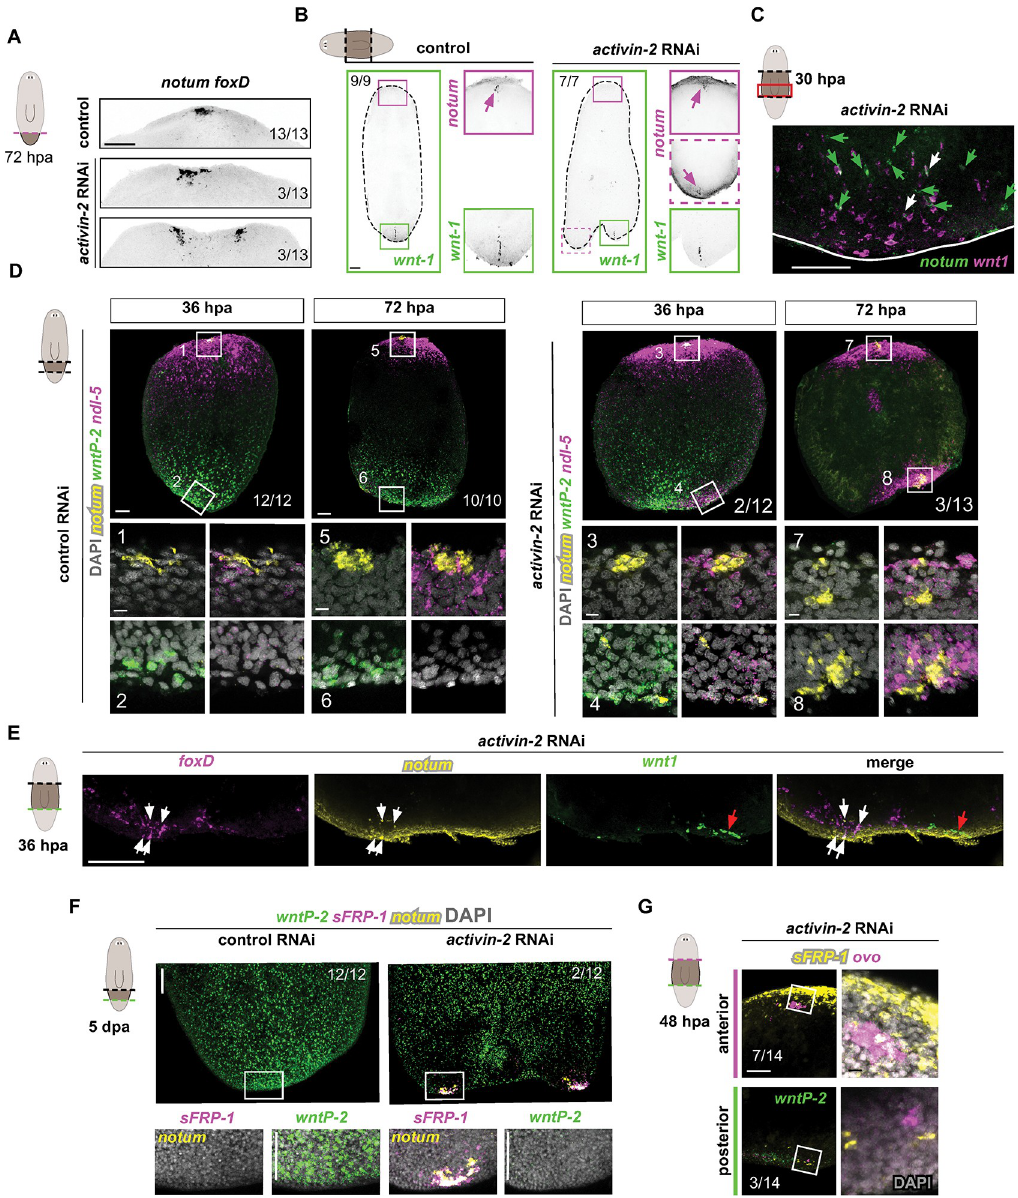
Fig 6. Ectopic wound-induced notum is correlated with the formation of an ectopic anterior pole in a Wnt-high environment. (A) FISH shows split anterior poles ( notum/ foxD+ ) in 72 hours regenerating activin-2 RNAi animals. (B) FISH show anterior ( notum ) and posterior ( wnt1 ) pole markers at 12 days post amputation in activin-2 RNAi animals. (C) FISH shows expression of notum and wnt1 in the same posterior-facing wound of an a ctivin-2 RNAi regenerating fragment at 30 hours post amputation. Green arrows show notum+ cells. White arrows denote cells that co-express notum and wnt1 . (D) FISH shows regenerating fragments resetting PCG ( ndl-5 , notum , wntP-2) expression and nucleating new anterior poles at different time points. activin-2 RNAi animals show ectopic anterior poles at posterior-facing wounds. Boxes indicate high magnification images shown below. (E) FISH shows anterior pole markers ( notum and foxD ), and the posterior pole marker ( wnt1 ) at the same posterior-facing wound of a regenerating fragment at 36 hours of regeneration. Zoom out seen in S7A Fig. (F) FISH shows posterior-facing wound of regenerating fragments at five days. Posterior related ( wntP-2 ) and anterior related ( notum/sFRP-1 +) gene expression by FISH. (G) FISH shows ovo+ eye progenitors and expression of anterior ( sFRP-1 ) and posterior ( wntP-2 ) PCGs at posterior-facing wounds of an activin-2 RNAi animal. Boxes: zoom ins on the right. Magenta, anterior-facing wound; green, posterior-facing wound. Scale bars, 200 μ m, except for high magnification panels in where they represent 10 μ m.